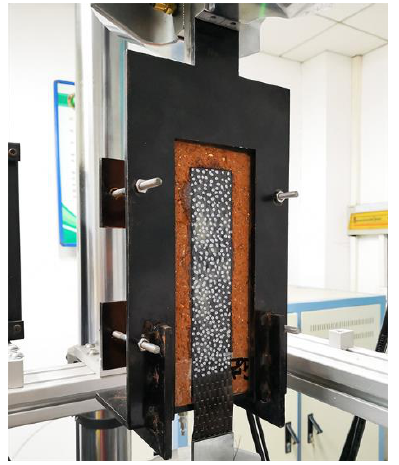
Figure 2. Fixture for single-lap shear tests.